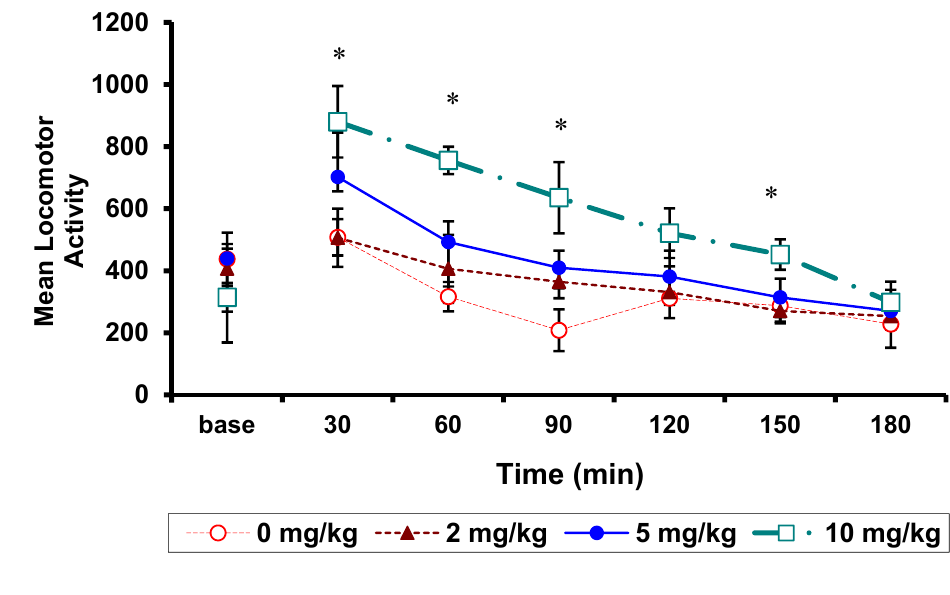
Figure 1. Wistar Kyoto (WKY) rats: Mean locomotor activity (breaks in passive infrared detectors (PIR) beams) at 30 min intervals, prior to (baseline; base) and following oral methylphenidate (MPH) administration over a 3 h period ( n = 5 per dose). * p < 0.017 for a significant difference between the 0 mg/kg and 10 mg/kg